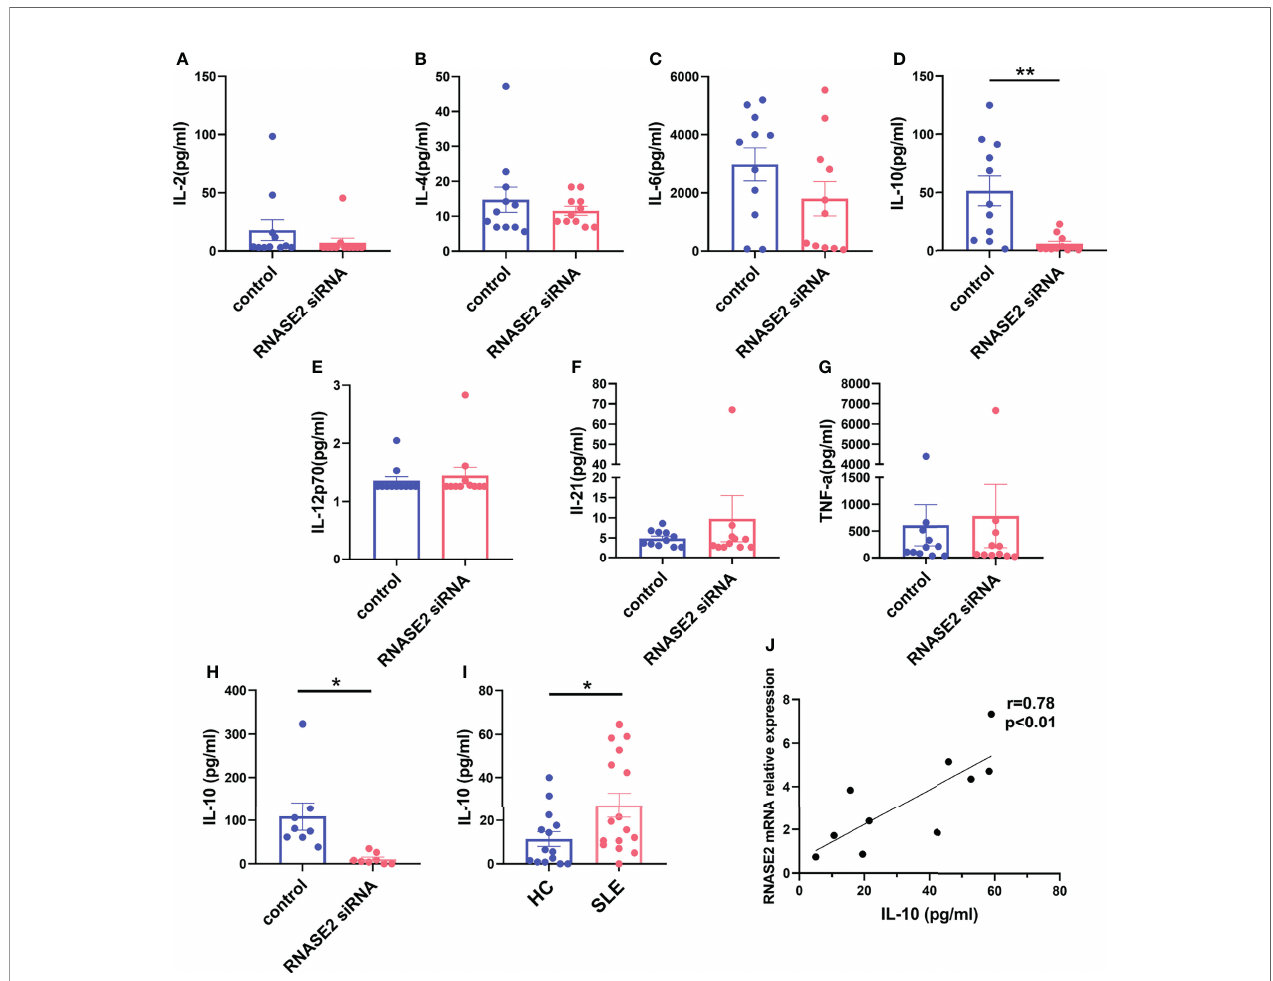
FIGURE 4 | IL-10 was a major effector of RNASE2. (A – G) The expression of multiple cytokines (IL-2, IL-4, IL-6, IL-10, IL-12p70, IL-21 and TNF- a ) in cultured supernatant was determined by using luminex liquid phase chip, among which only IL-10 level was signi fi cantly decreased in RNASE2 silencing group (n=11). The lower limit of detection (LLOD) for each cytokine was 2.96 pg/ml, 5.61 pg/ml, 0.72 pg/ml, 0.74 pg/ml, 1.26 pg/ml, 2.69 pg/ml and 0.98 pg/ml respectively, and levels lower than LLOD were regarded as having the minimum detection value. (H) Independent sample validation by ELISA con fi rmed the reduction of IL-10 level in cultured supernatants after RNASE2 silencing (n=8) (LLOD 0.05pg/ml). (I) In vivo study showed the level of plasma IL-10 was increased in SLE patients (n=16) compared with healthy controls (n=14). (J) Plasma IL-10 levels in SLE patients were closely linked to peripheral RNASE2 mRNA expression (n=10). Data are presented as mean ± SEM, *p < 0.05, **p <